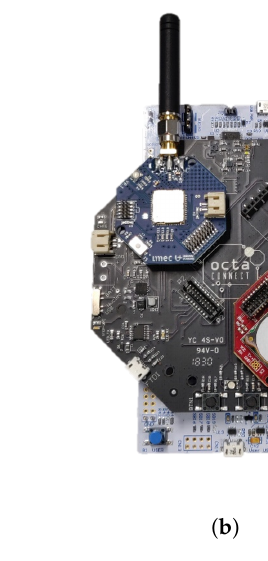
Figure 7. Deployment setup ( a ) Hardware setup overview. ( b ) Example configuration with CO 2 sensor